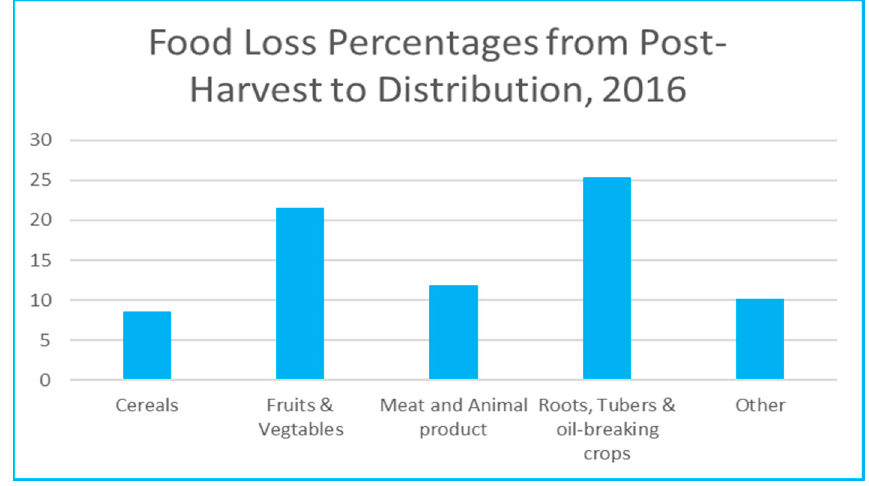
Figure 1. Food loss percentages along the supply chain (Data based on FAO 2019 report [3]).